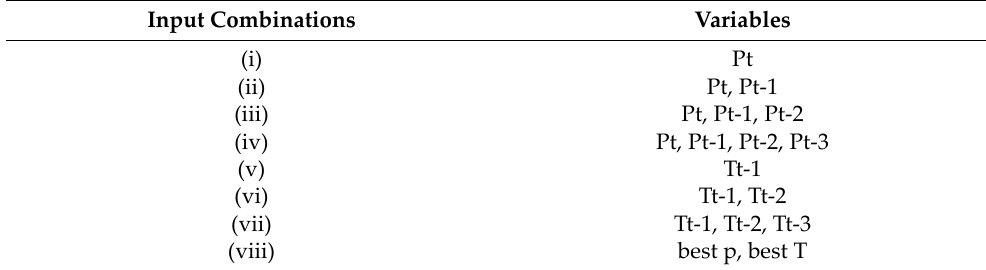
Table 1. The input combinations used for model development. Input Combinations